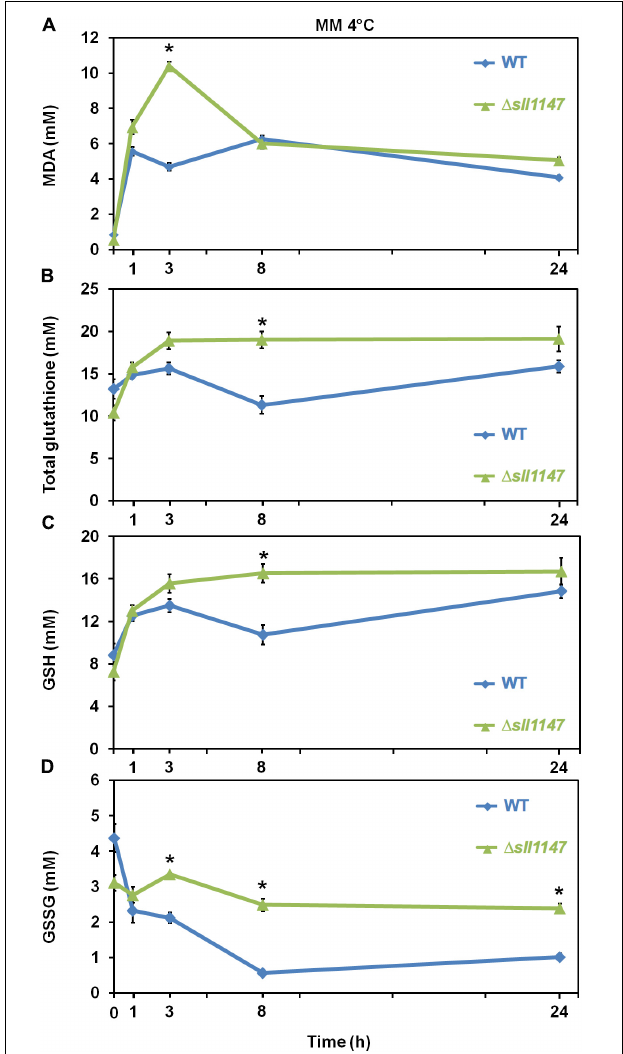
FIGURE 6 | In response to cold, the (cid:49) sll1147 sensitive mutant transiently accumulates peroxidized lipids, GSH and GSSG. Kinetic analysis of the influence of cold temperature exposure (4 ◦ C) on the abundance of peroxidized lipids measured as MDA content (A) , total glutathione (B) , GSH (C) , and GSSG (D) in Synechocystis WT and mutant (cid:49) sll1147 . Data are expressed as the mean ± SD of three assays and ∗ indicates significant difference between mutant and WT ( t -test, P <